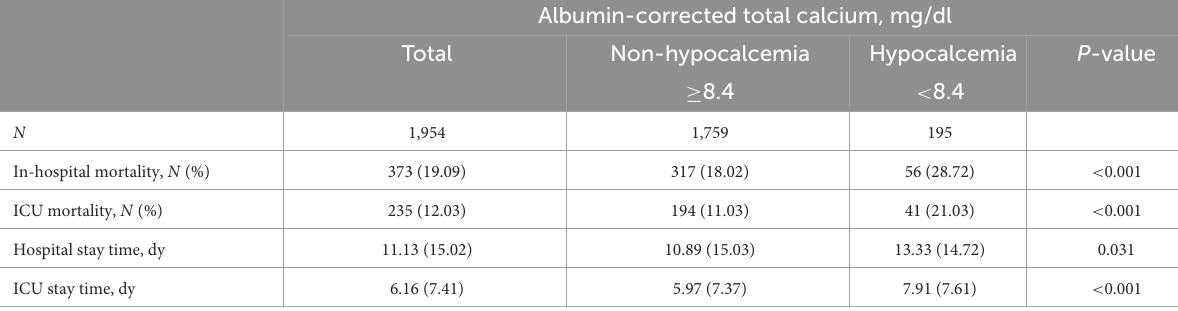
TABLE 2 The outcomes of patients in hypocalcemia and non-hypocalcemia